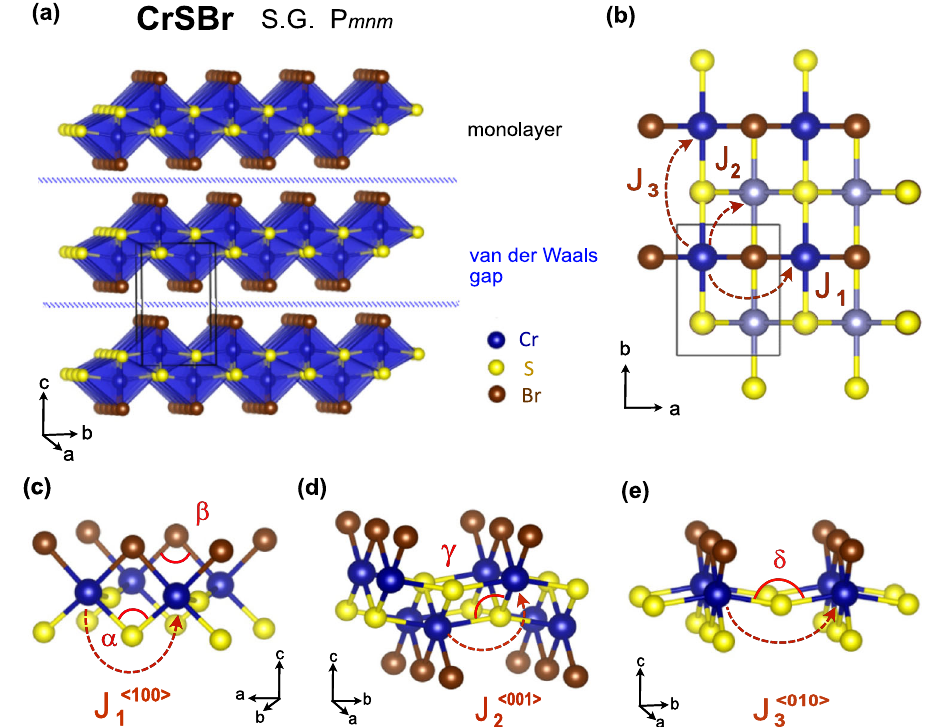
Fig. 1 | Structure and Bonding in CrSBr. a Crystal structure of CrSBr within the Pmnm spacegroup(S.G.)showingthecoordinationpolyhedraaroundtheCratoms and the van der Waals gap separating the CrSBr monolayers. b Basal plane pro- jection, showing the square-lattice arrangement of Cr cations within each layer. A